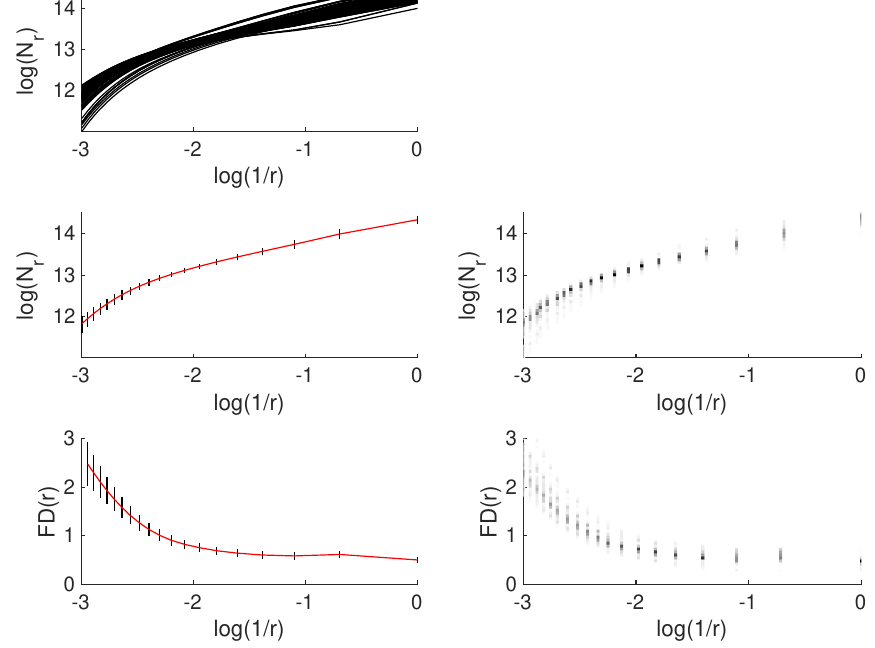
Figure 6. Exemplary results for box-counting analysis for single image (standard deviations are shown as a vertical line in left figures; raw distributions are shown in right figures).